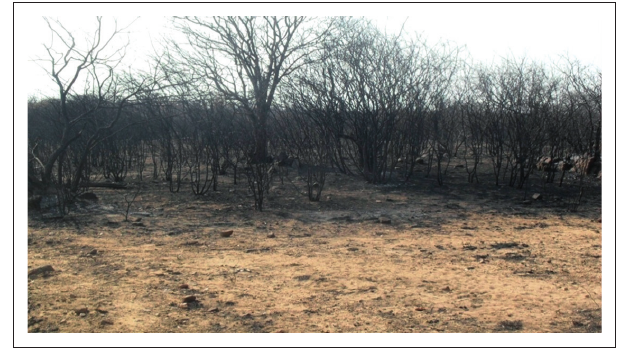
Source : Photograph taken by S. Phiri FIGURE 4: Ward 20 severely burnt by high-profile, mechanised panners. TABLE 5: Catchment dam levels. Dams